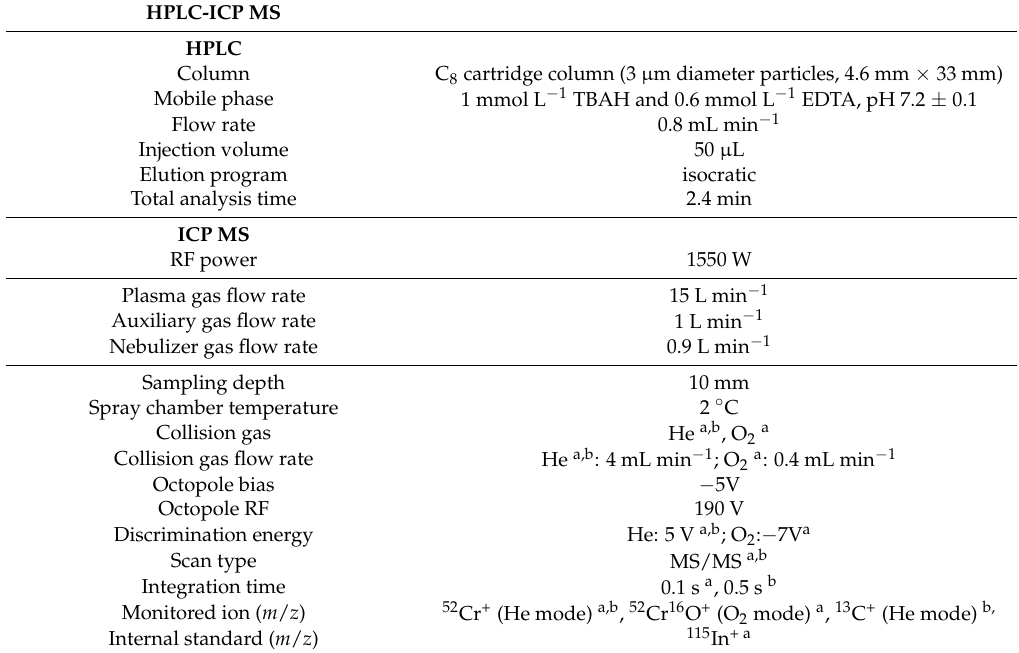
Table 1. Optimal operational conditions for ICP MS and HPLC-ICP MS